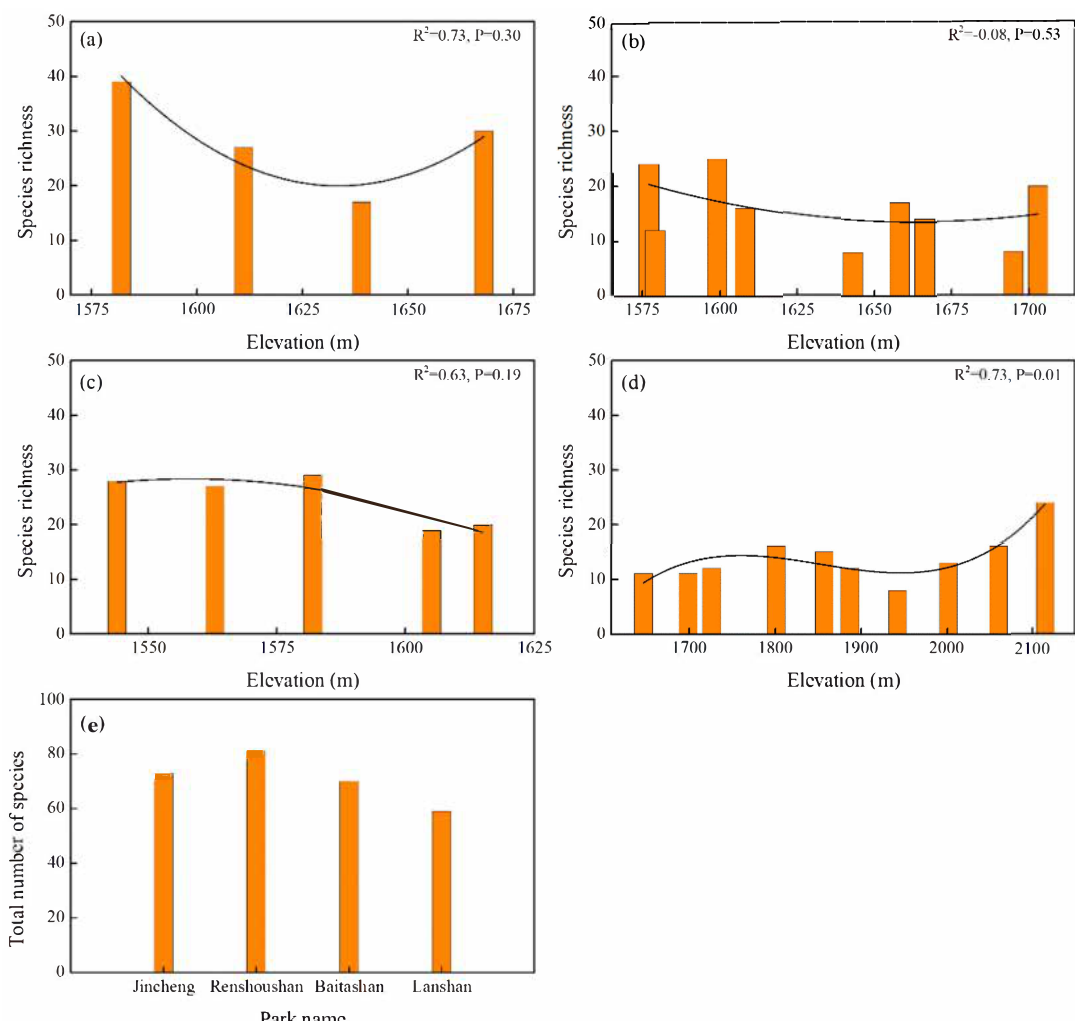
Figure 4. Variation in plant species diversity by altitude and the total number of the plant species in the four each parks. ( a ) Jincheng Park; ( b ) Renshoushan Park; ( c ) Baitashan Park; ( d ) Lanshan Park and ( e ) the total number of the plant species of each